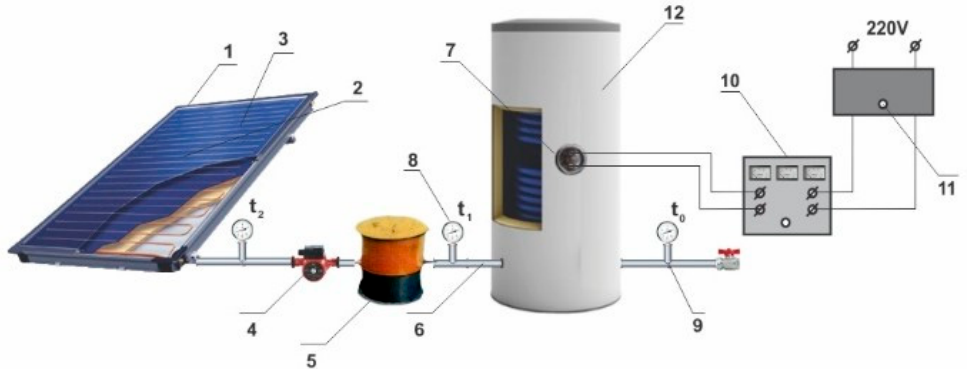
Figure 1. Principal diagram of solar-heat supply system [24] (Wojcik, W., Amirgaliyev,